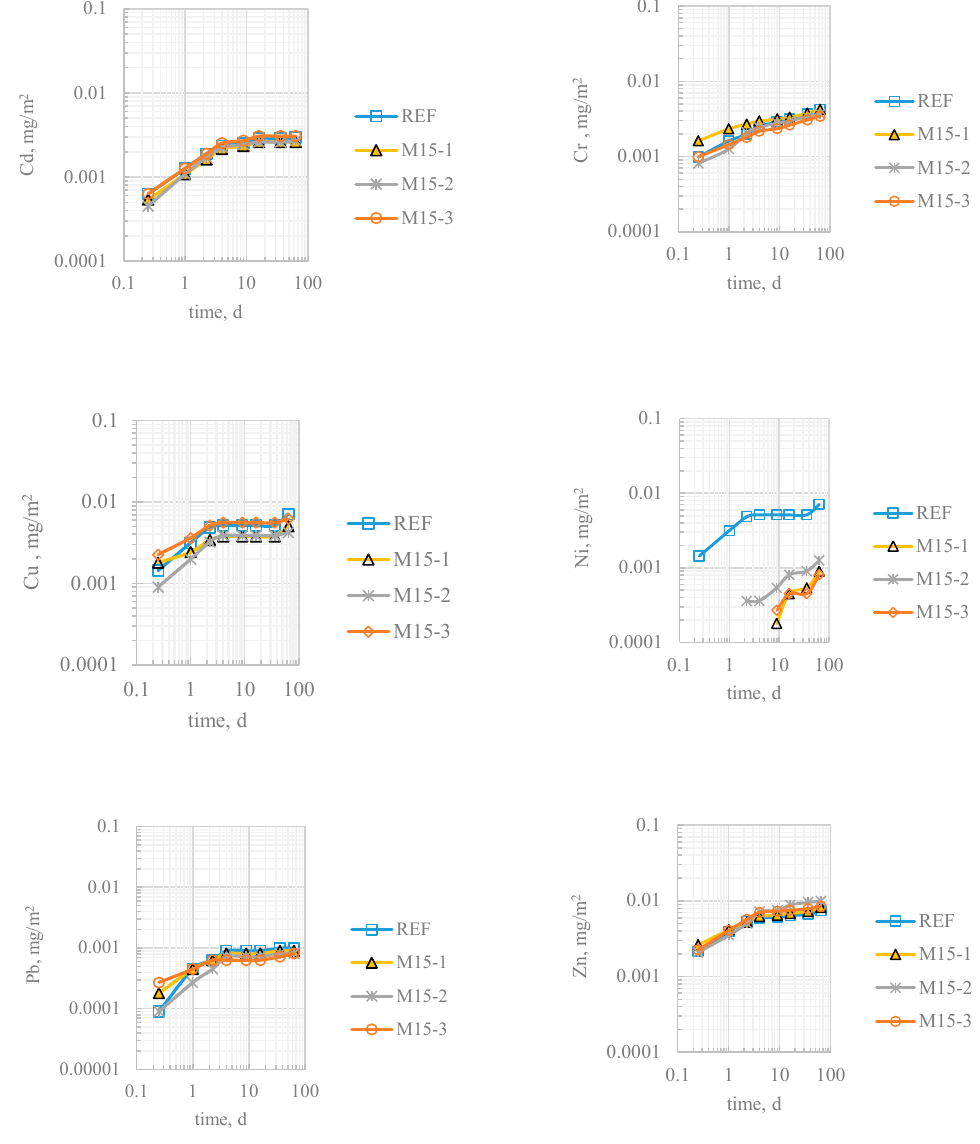
Figure 2. Cumulative leaching of heavy metals from the monolithic samples over time.